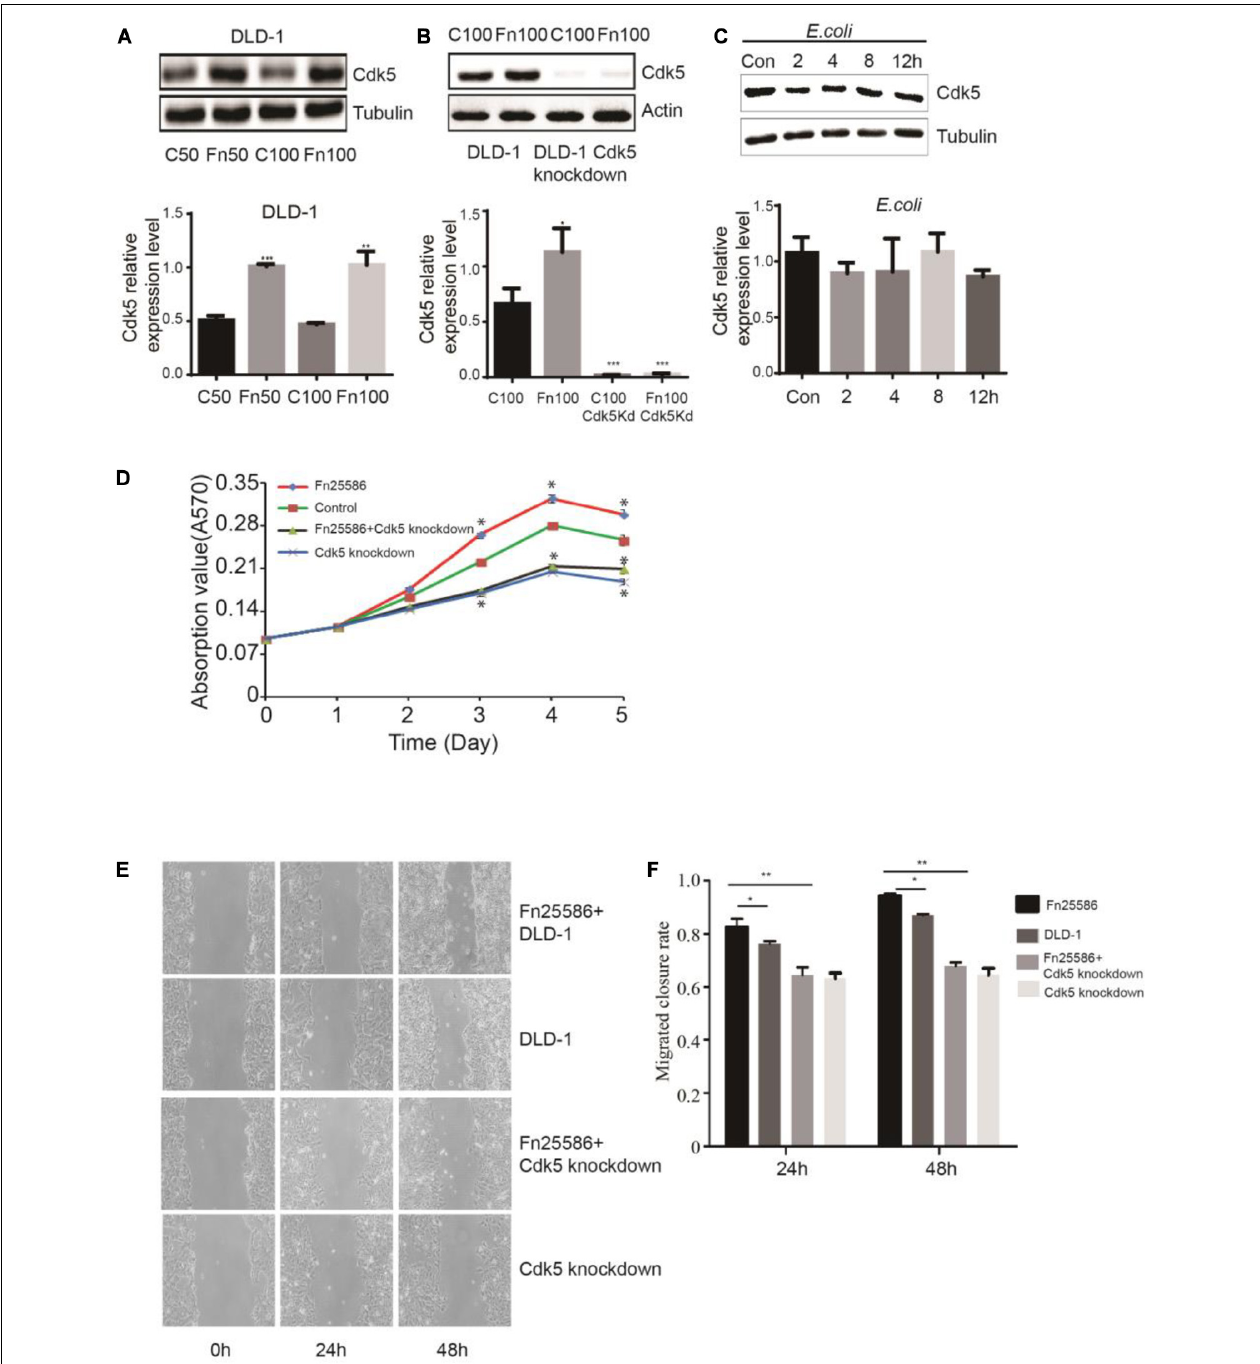
FIGURE 2 | Fusobacterium nucleatum regulates DLD-1 cancer cell proliferation through upregulated cyclin-dependent kinase 5 (Cdk5) expression. (A) The protein levels and quantification of Cdk5 in DLD-1cells treated with F. nucleatum were measured by Western blot (WB) analysis. Data are expressed as mean ± SEM from at least three independent experiments. *** P < 0.001 and ** P < 0.01 vs. control. (B) The protein levels and quantification of Cdk5 in DLD-1 cells and Cdk5-knockdown DLD-1 cells treated with F. nucleatum were measured by WB analysis. Data are expressed as mean ± SEM from at least three independent experiments. *** P < 0.001 and * P < 0.05 vs. control. (C) The protein levels and quantification of Cdk5 in DLD-1 cells cocultured with Escherichia coli (DH5 α ) over time were measured by WB analysis. Data are expressed as mean ± SEM from at least three independent experiments. (D) F. nucleatum can promote the proliferation of colorectal cancer cells through Cdk5. (E) Wound-healing assay in DLD-1 cells and Cdk5-knockdown DLD-1 cells, respectively, after treated with F. nucleatum ( × 400). (F) Quantification of wound-healing assays. Data are expressed as mean ± SEM from at least three independent experiments. * P < 0.05 vs. DLD-1, ** P < 0.01 vs. Cdk5-knockdown